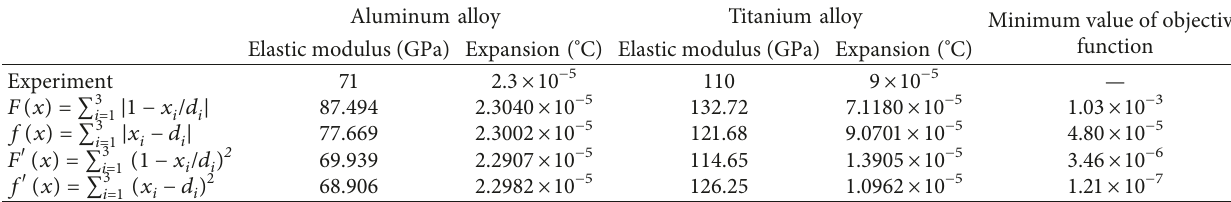
Table 5: Results Comparison of different objective functions.